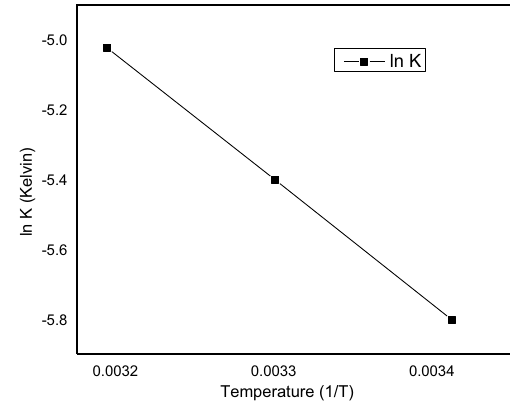
Fig. 17 Arrhenius plot for MR dye sorption onto SCTJF